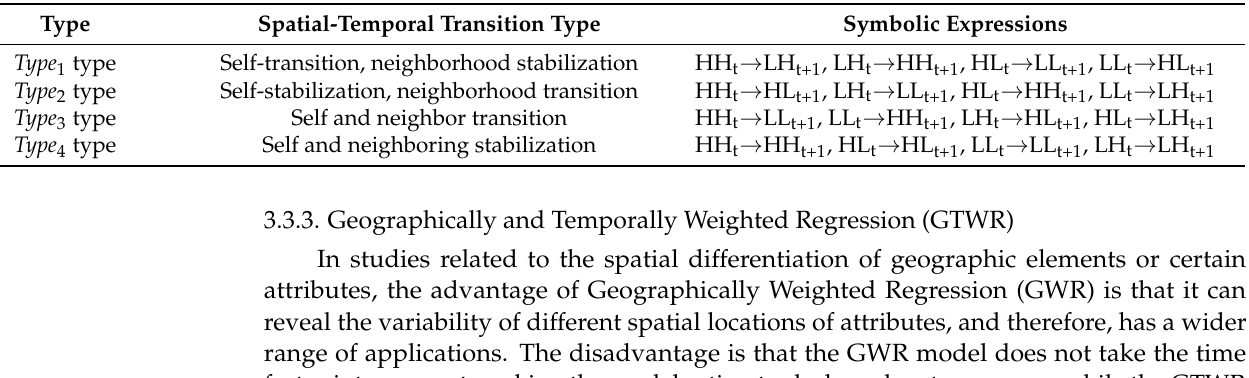
Table 2. Basic types of spatial-temporal